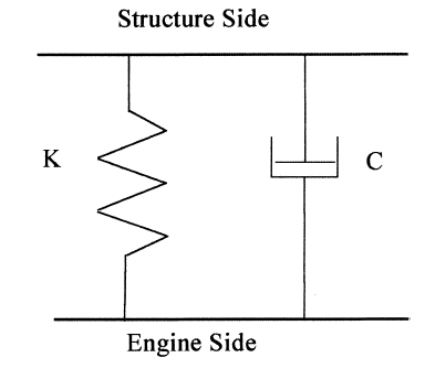
Fig. 1. Mechanical model of the elastomeric mount [31].